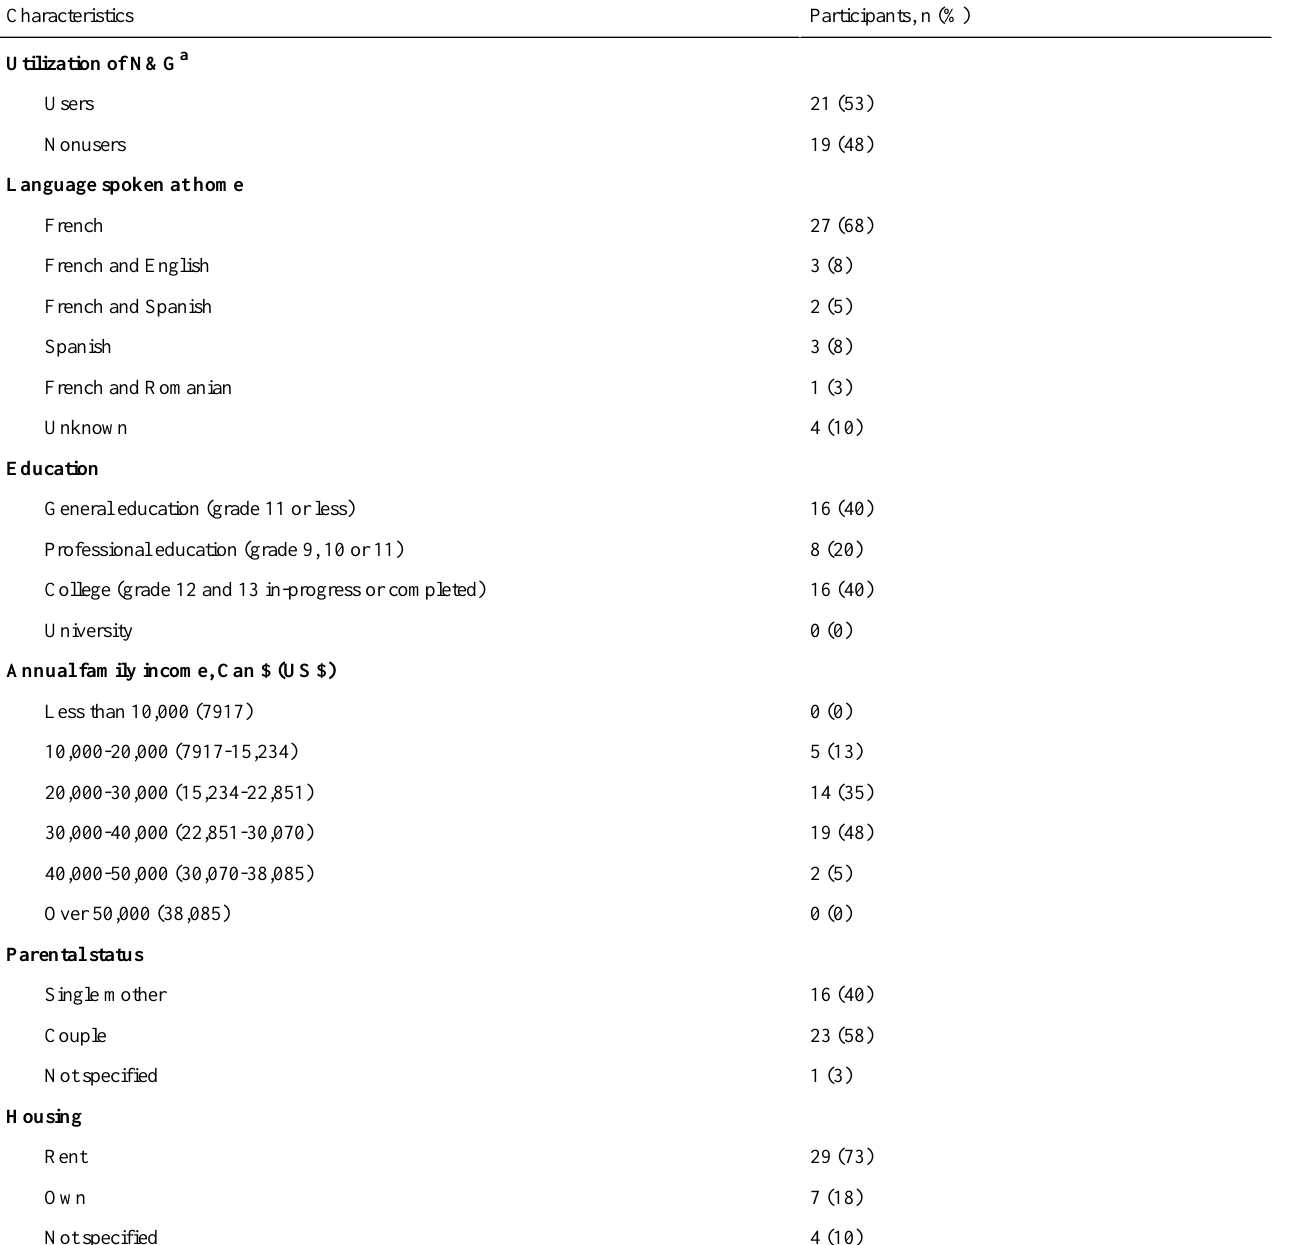
Table 4. Qualitative component: sociodemographic characteristics of the participants